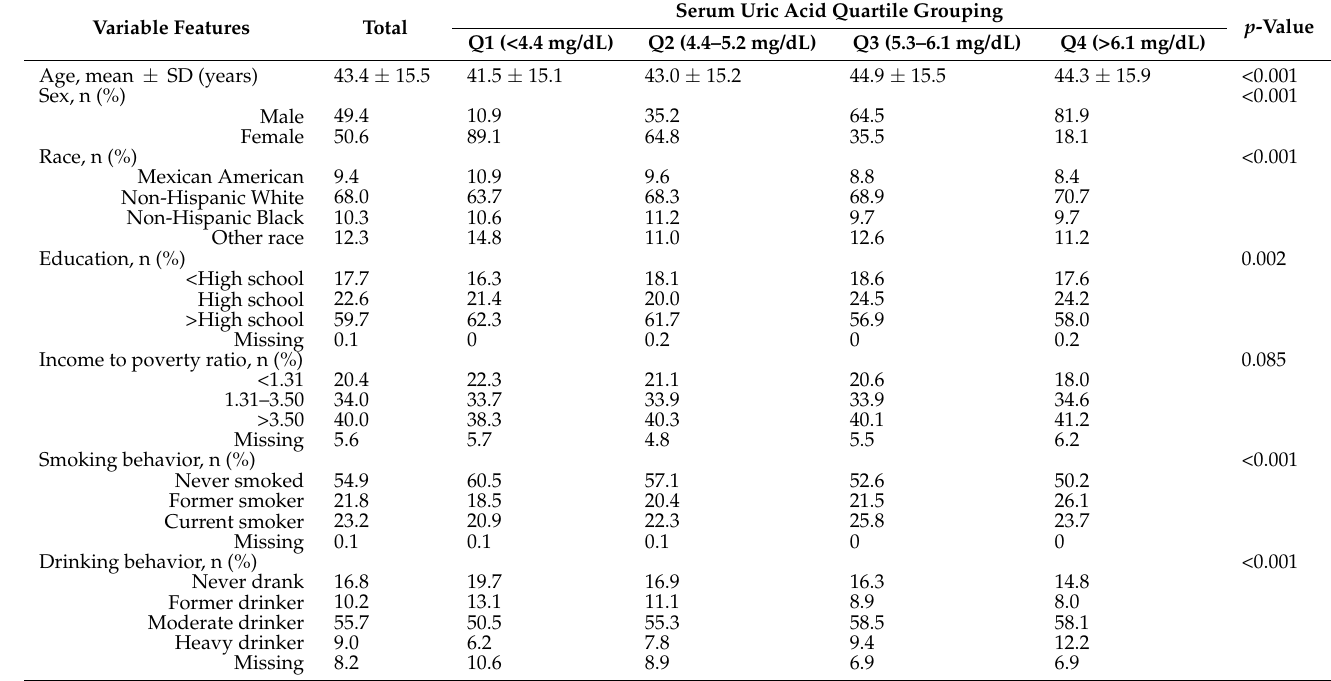
Table 1. Population characteristics data of study participants.